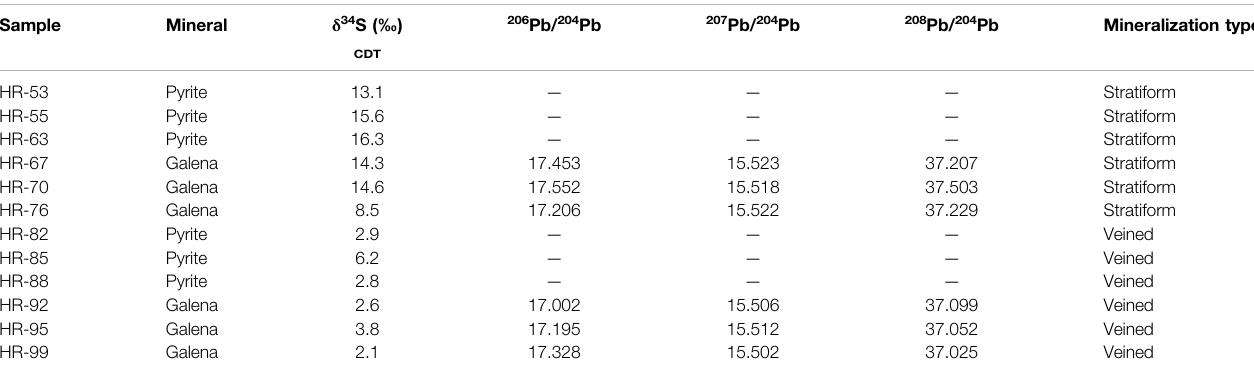
TABLE 3 | Sulfur and lead isotope data for pyrite and sphalerite from the Haerdaban Pb-Zn deposit. Sample